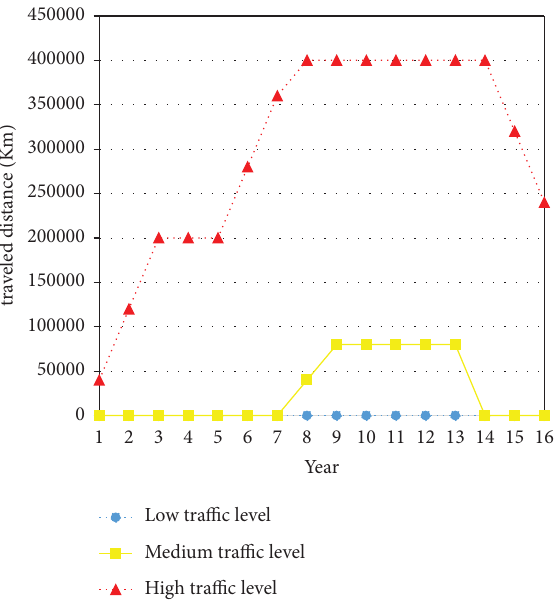
Figure 6: Traveled distance of electric vehicles for diferent levels of trafc